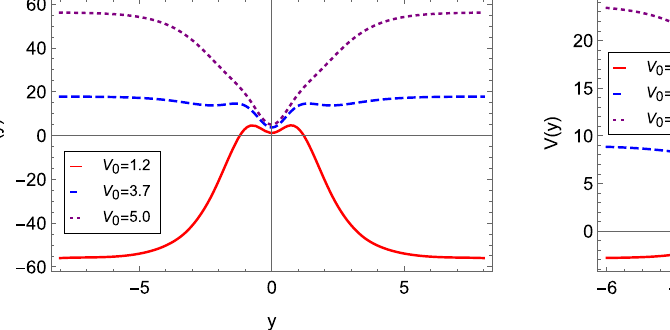
Fig. 2 Numerical solutions for the potential V ( y ) from Sect. 3.2 with ϕ = 2, ψ = 1, A = 1 and k = 1. In the left panel we provide solu- 0 0 0 tions for the boundary conditions V 0 = 1 . 2, V 0 = 3 . 7 and V 0 = 5 . 0. It